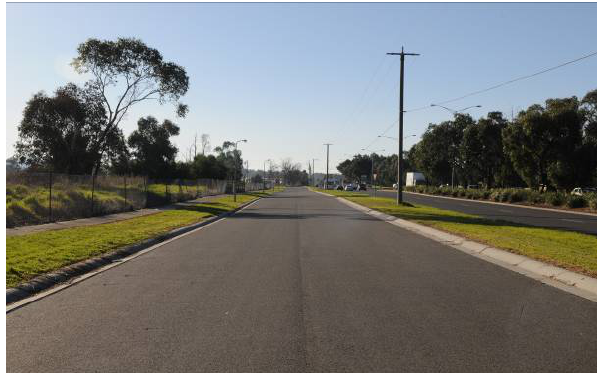
Fig. 2. Test site. Service lane, Dorset Road, Bayswater, Victoria Australia.